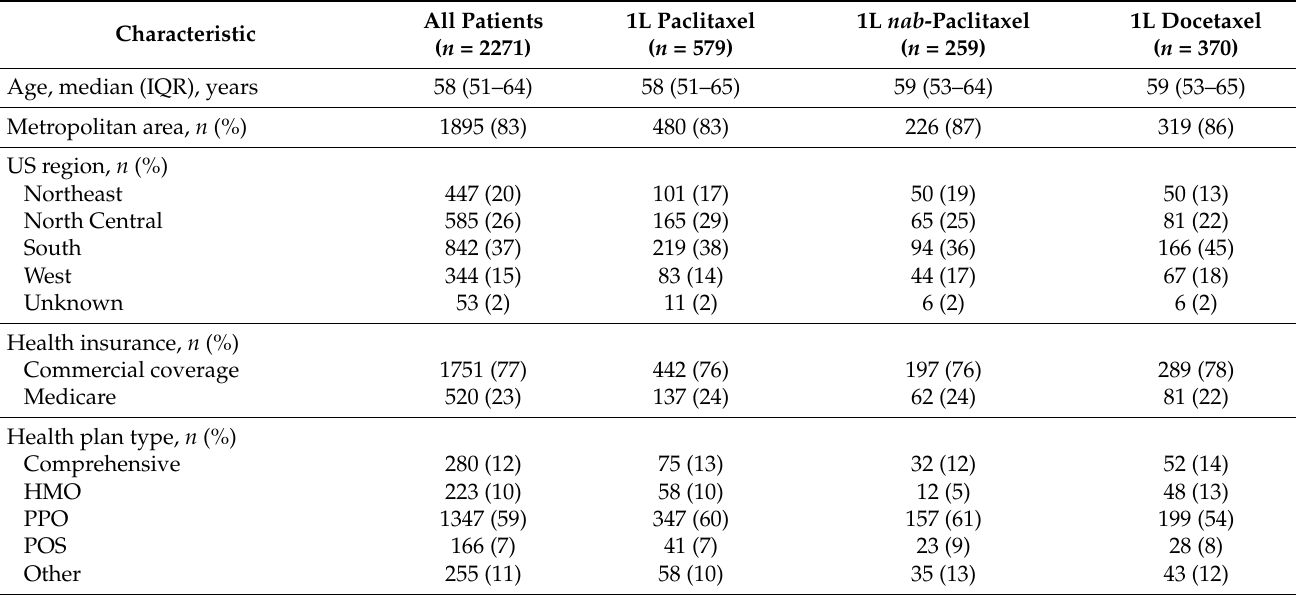
Table 1. Patient demographic and clinical